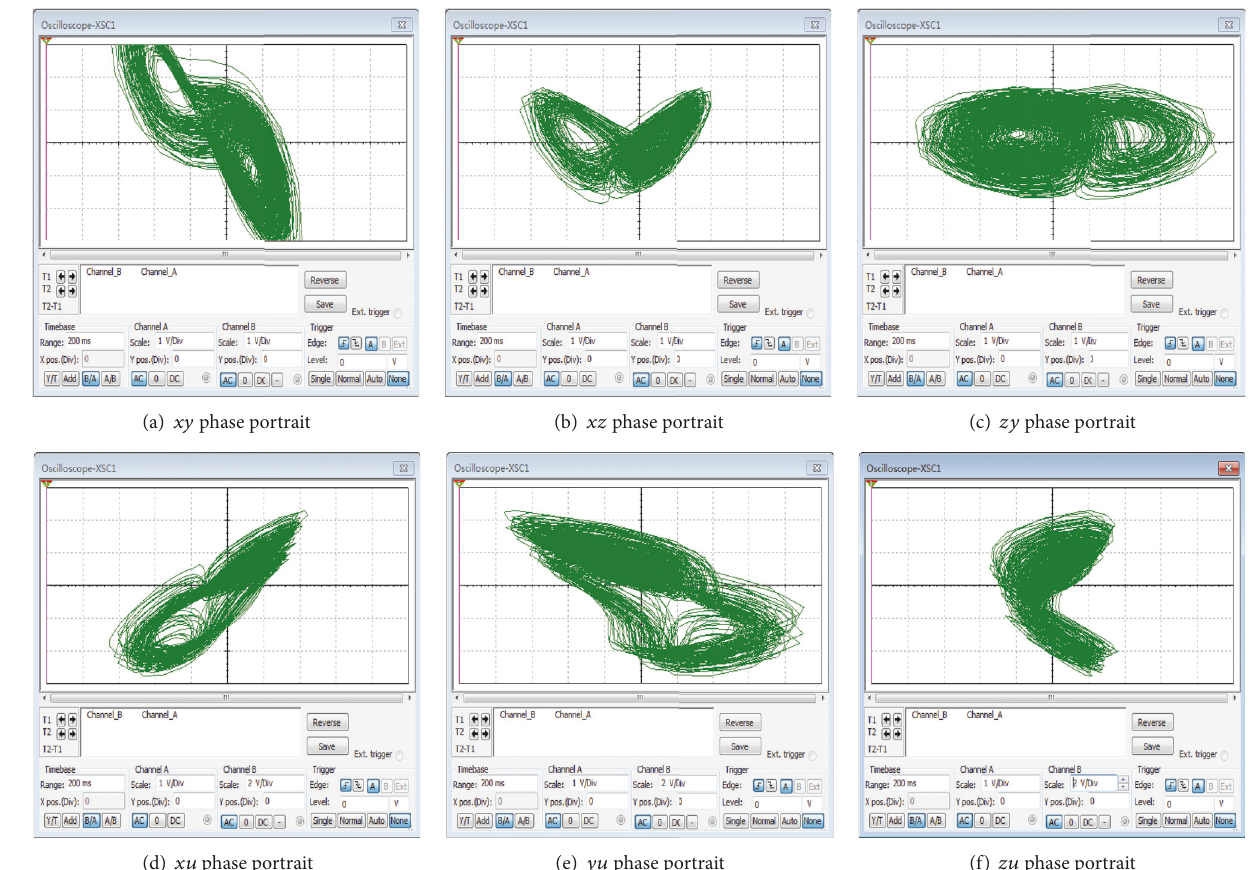
Figure 6: (𝑦 + 𝑧) - 𝑢 - 𝑥 hyperchaotic phase portraits with